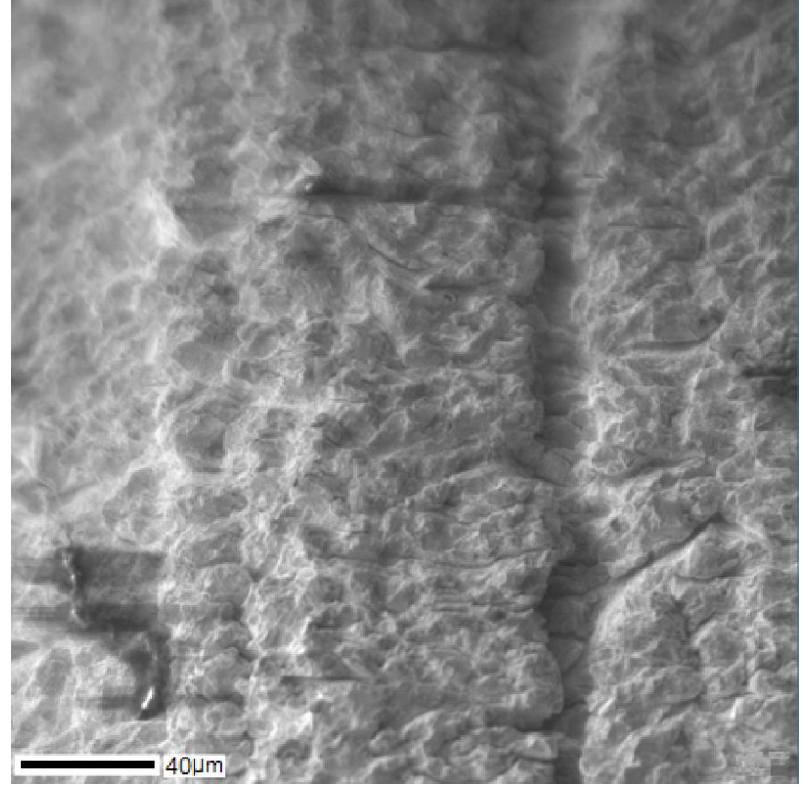
Figure 10. The surface of the Ti–28Nb–5Zr wire after drawing.